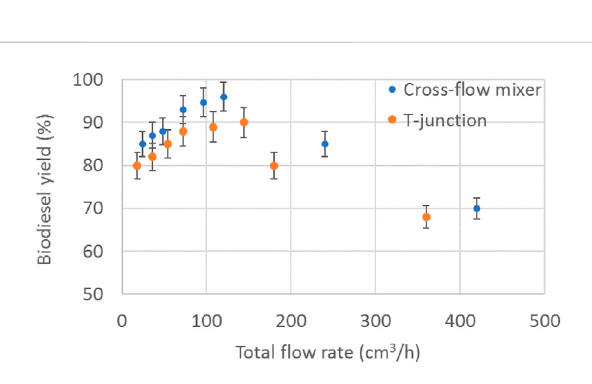
FIGURE 10 Effect of total fl ow rate on the biodiesel yield. (Molar ratio 10, temperature 60 ° C, residence time 1 min, catalyst concentration 1.6%